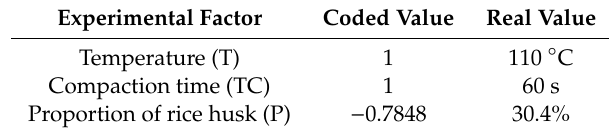
Table 13. Values of experimental factors to maximize the composite desirability function.